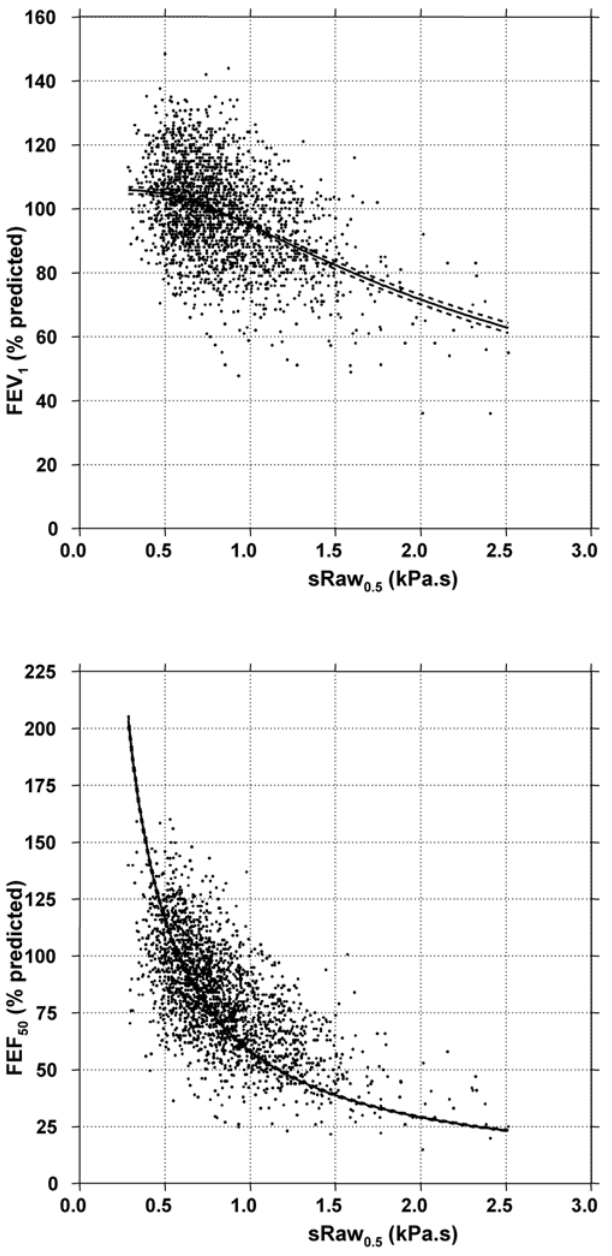
Figure 1. Relationships between sRaw and forced expiratory flows: observed data and non-linear regression modelling. Non-linear regression modelling showed that the curves based on our model equations (1’) and (2’) (see equations in the Methods) fitted well the scatter plots sRaw 0.5 for both FEV 1 (upper panel) and FEF 50% (lower panel), respectively. results were confirmed when analysing LFTs from both centers separately.